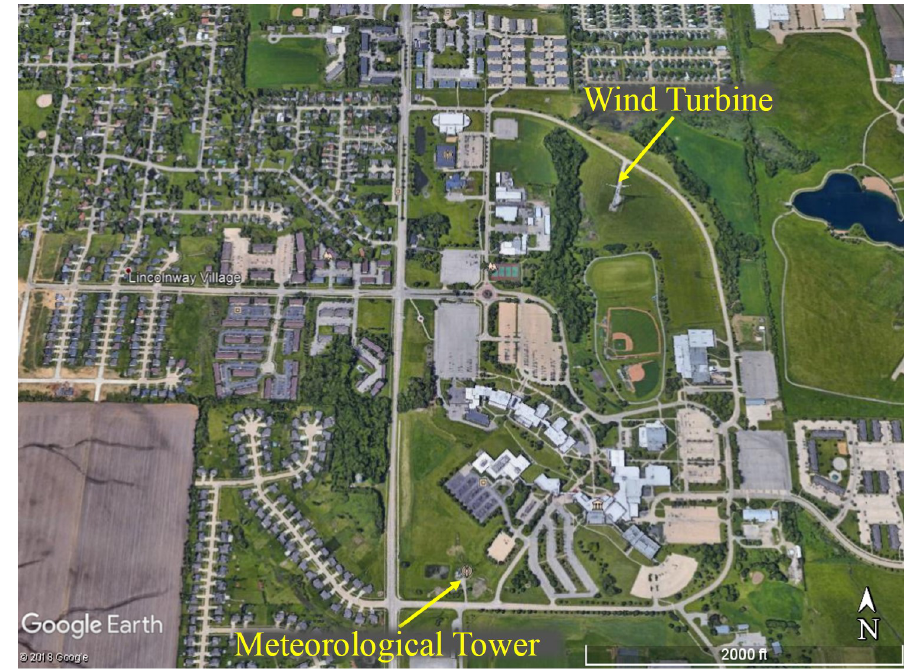
Figure 3. Location of wind turbine of study in relation to 106 m met tower. Kirkwood community college campus is located in between. Image: